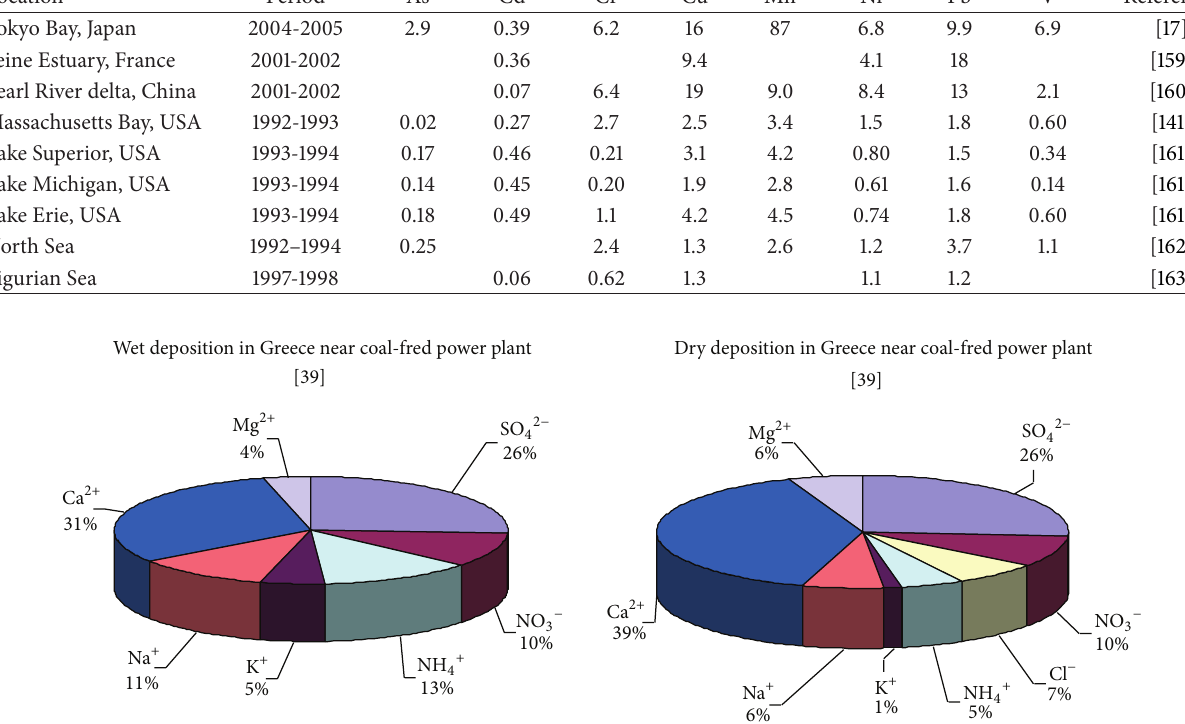
Table 9: Comparison of mean wet + dry deposition fluxes (mgm −2 yr −1 ) of trace elements in aquatic regions. Location